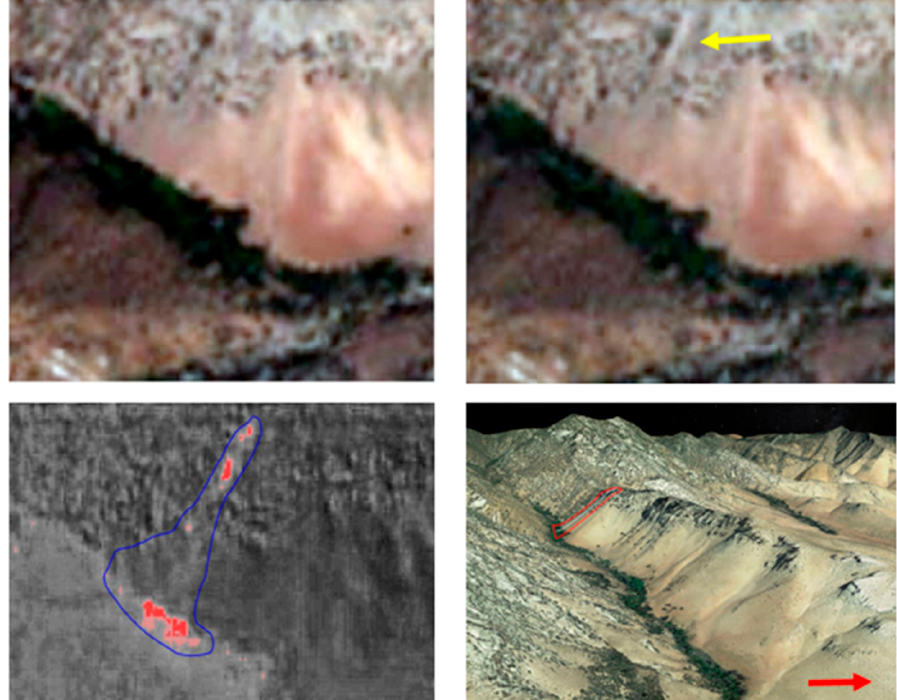
Figure 15. Large rockfall event in an area not predicted by ShakeMap as having a high probability of failure. Upper left : 3 July Sentinel-2 image. Upper right : 10 July Sentinel-2 image. Yellow arrow points to the initial area of failure. Bo tt om left : stretched di ff erenced results. Red pixels show large positive change in brightness. Bo tt om right : Google Earth view looking northwest up Grapevine Canyon with the Sierra Nevada crest forming the skyline (Sawtooth Peak to right) (Image date 1 July 2017). The red-boxed area contains the individual mapped feature shown in the bo tt om left box. North is to the top of all images except for the bo tt om right perspective view, where north is to the right and shown with a red arrow.